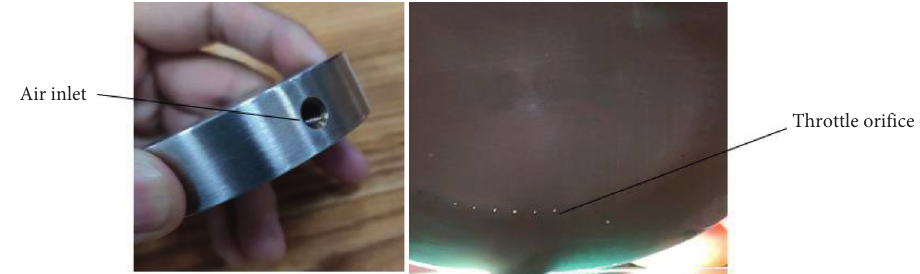
Figure 11: Physical drawing of aerostatic bearing of the annular array microporous